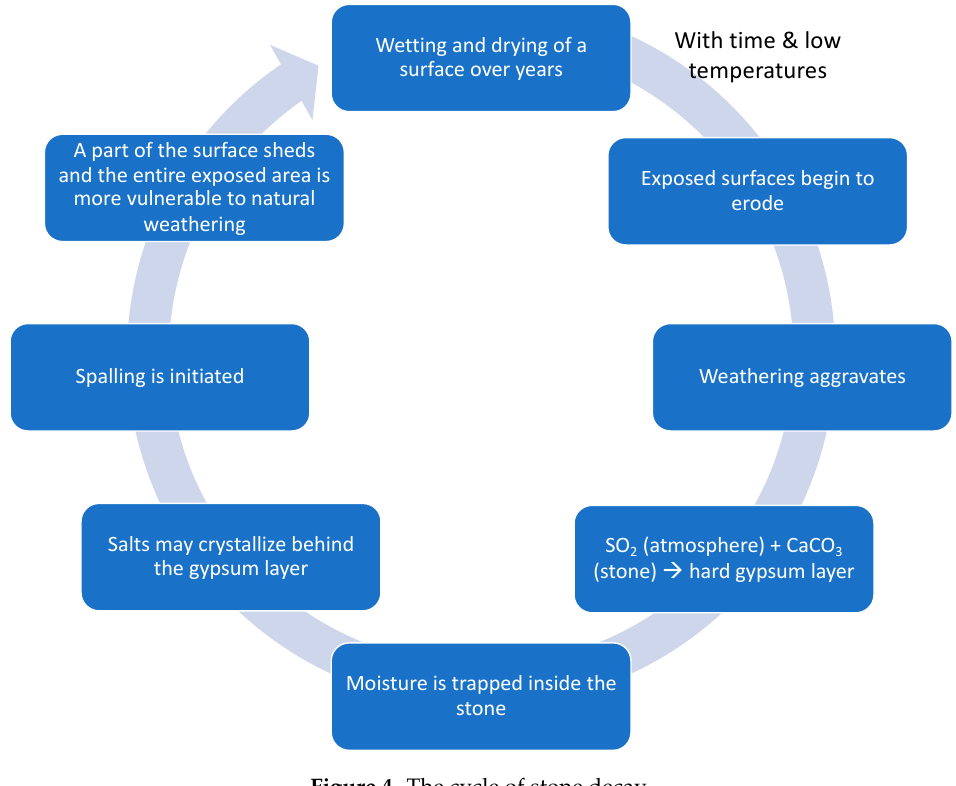
Figure 4. The cycle of stone decay.